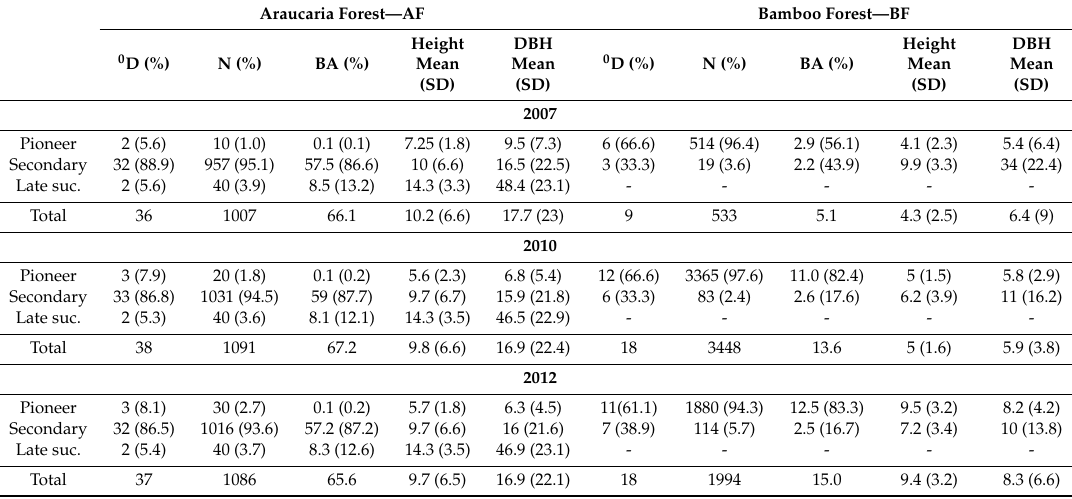
Table 4. Results of the analysis between AF and BF based on richness ( 0 D), number of trees (N; individuals per ha), basal area (BA; m 2 ) and their respective percentages, and mean height and diameter at breast height (DBH) (meters and centimeters, respectively) and their respective standard deviation (SD) for each ecological group by